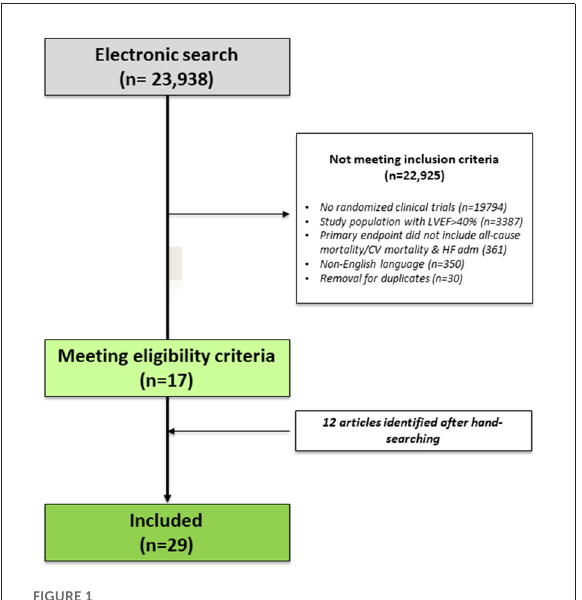
FIGURE1 Flow-chart of the study